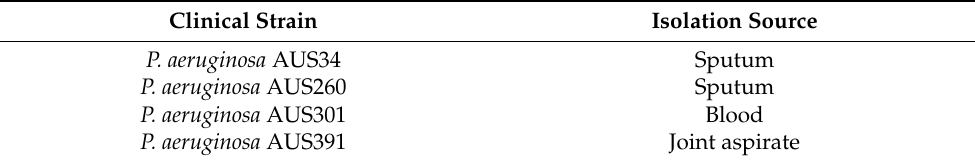
Table 1. Clinical strains of P. aeruginosa used to isolate new phages in this study. Clinical Strain Isolation